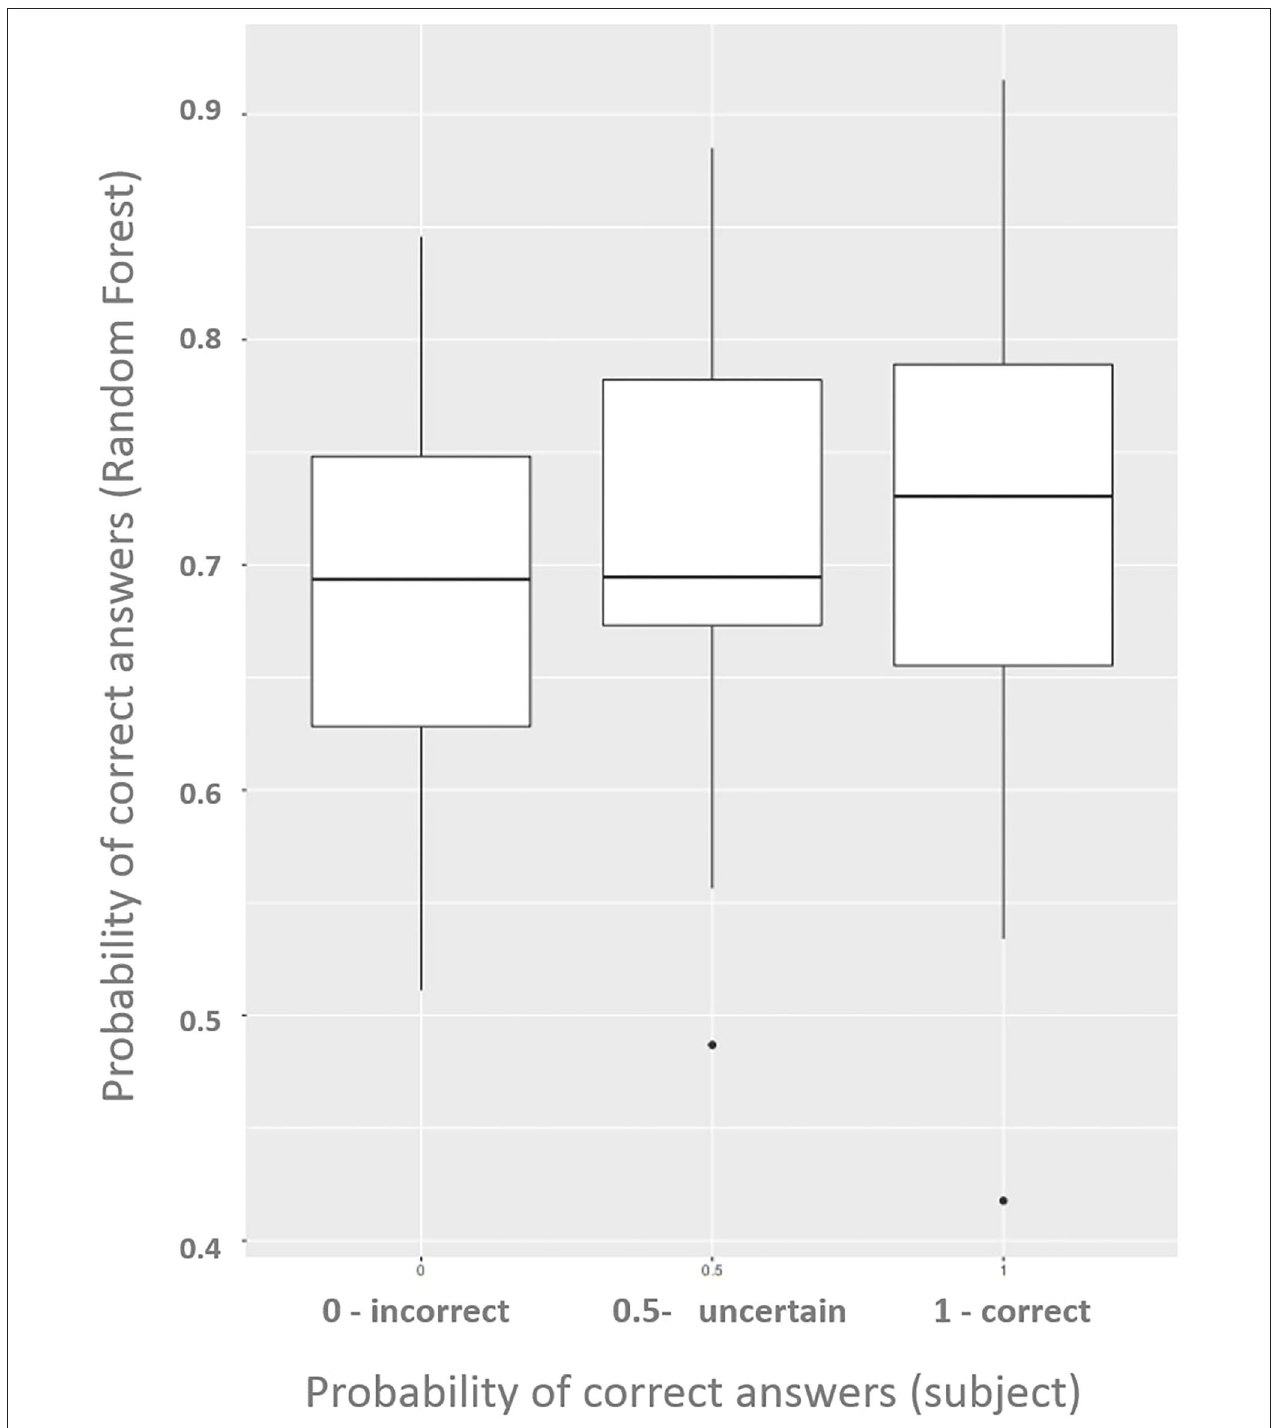
FIGURE 7 | Boxplots show differences between the groups: 1, certainly right exercise; 0.5, not sure/next idea; 0, probably wrong/random guess.